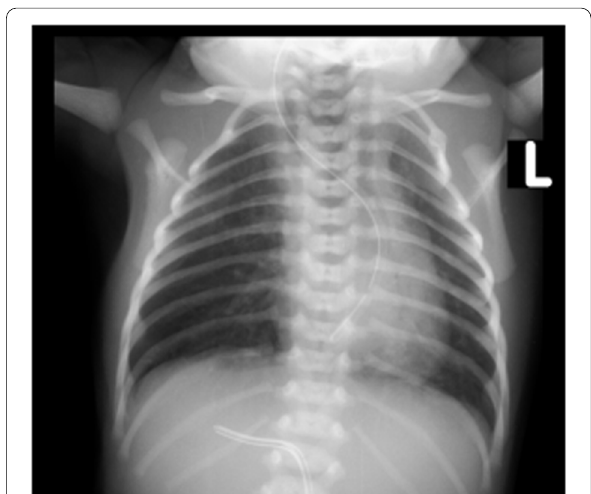
Fig. 2 Coiled NGT in the chest and absent gastric bubble